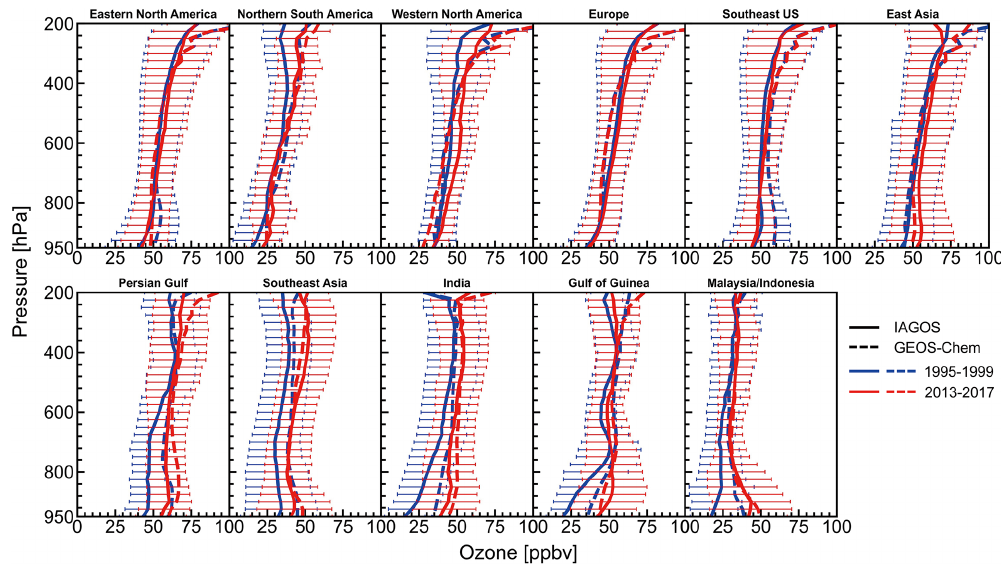
Figure 3. Comparison of IAGOS observations (solid line) and simulated (dashed line) ozone vertical profiles for 11 IAGOS regions from 1995–1999 (blue line) to 2013–2017 (red line). Horizontal bars are standard deviations in the